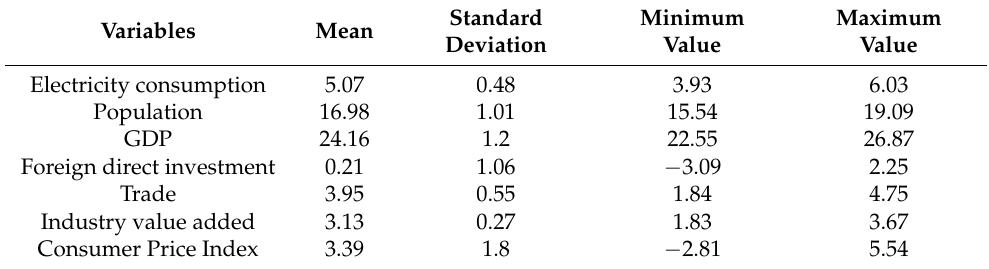
Table 1. Descriptive statistics.